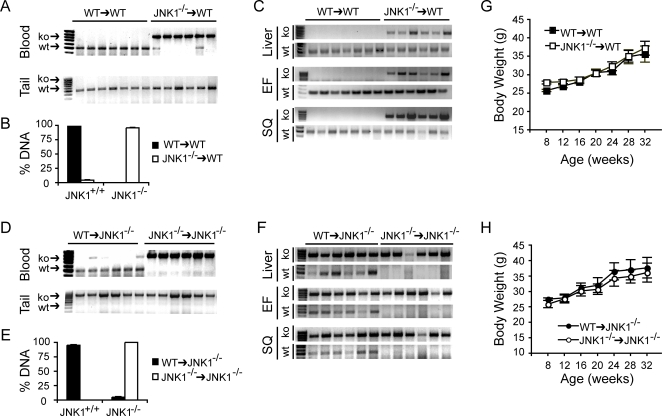
Generation of JNK1-deficient radiation chimeras using bone marrow transplantation.The extent of engraftment of the transplanted cells in WT recipients after bone marrow transplantation was determined using genomic DNA isolated from whole blood and quantified with PCR-based allele distribution (A and B). Genomic DNA harvested from tail confirmed the presence of only the recipient genotype (A) while genomic DNA from liver, subcutaneous fat, and epididymal fat tissues (C) confirmed engraftment of donor (Jnk1-deficient) cells in WT recipients. Genomic DNA isolated from blood was quantified as in panel A except in the Jnk1−/− recipient groups (D and E). Genomic DNA isolated from the liver, subcutaneous fat, and epididymal fat tissues (F) of Jnk1−/− recipients confirmed the genotype and engraftment, respectively. At 8 weeks of age, all WT (G) and Jnk1−/− (H) recipient chimeras transplanted with WT or Jnk1−/− bone marrow cells were placed on high fat diet and body weights were monitored for the duration of experiments.